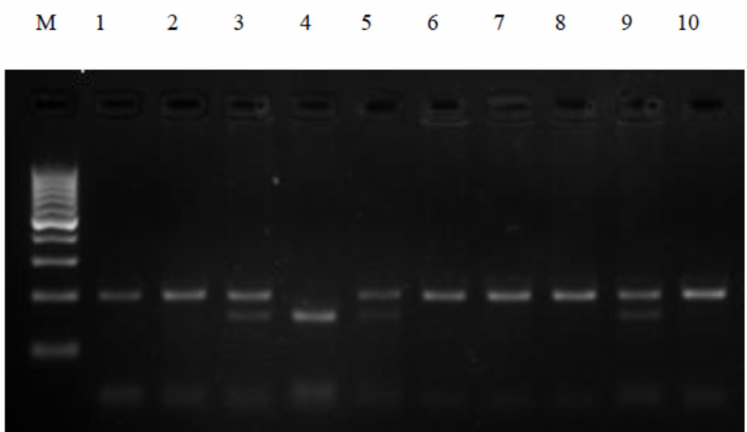
Figure 1. Restriction analysis of the 609C > T polymorphism in the NQO1 gene. Lane M—100 bp ladder marker; lane 1,2,6–8,10—CC genotype; lane 3,5,9—CT genotype; lane 4—TT